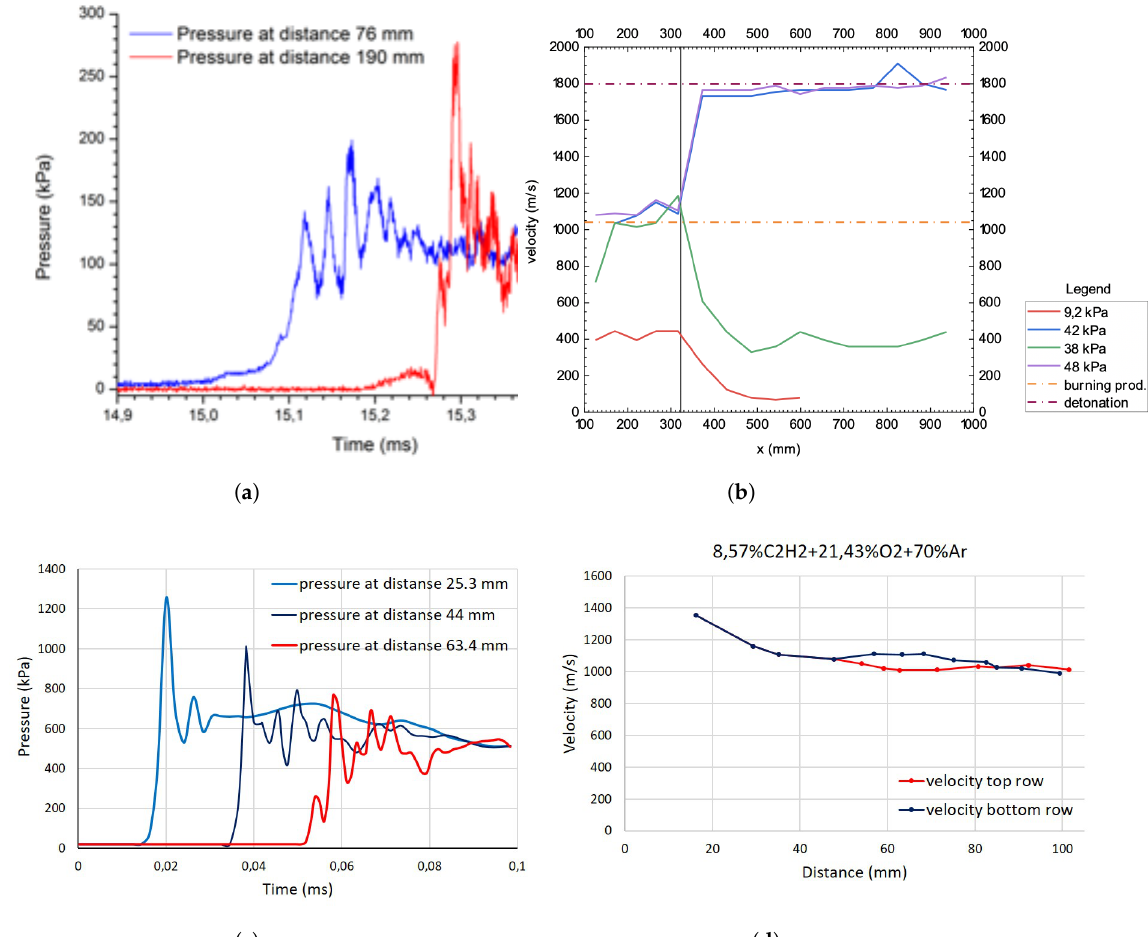
Figure 4. Experimental results for the 70% argon-diluted mixture of acetylene–oxygen: ( a )—the pressure record at two gauge positions from experiment; ( b )—average wave velocity in the obstructed section (to the left of the vertical line at x ≈ 320) and upon exit from it at various initial pressures. Computational results for the same mixture: ( c )—the pressure record at three positions in the channel ( G 1 − G 3, see Figure 3(a1)); ( d )—the average wave velocity in the channel as a function of distance from the left end of the channel; the velocity is measured near the top and bottom walls of the channel. The speed of sound in the products is 1042 m/s and the CJ velocity is 1798 m/s at p 0 = 0.2 atm, both are indicated in ( b ) as horizontal dash-dot